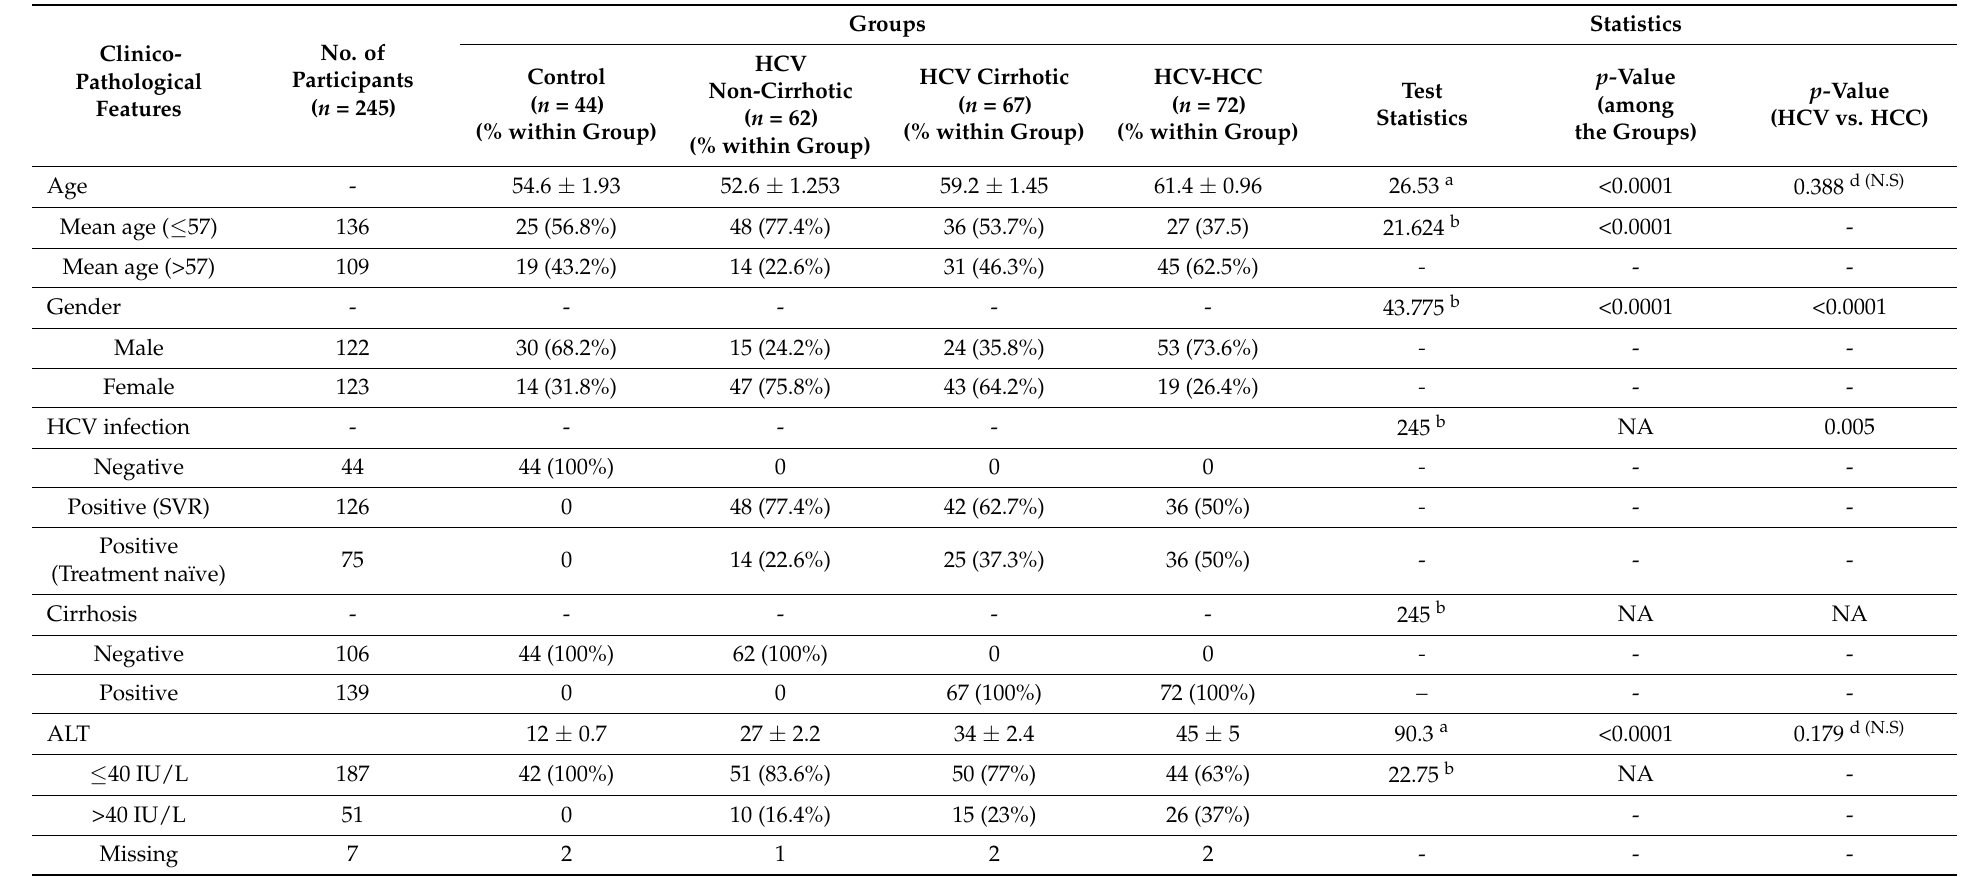
Table 1. Clinicopathological and demographic features of the study